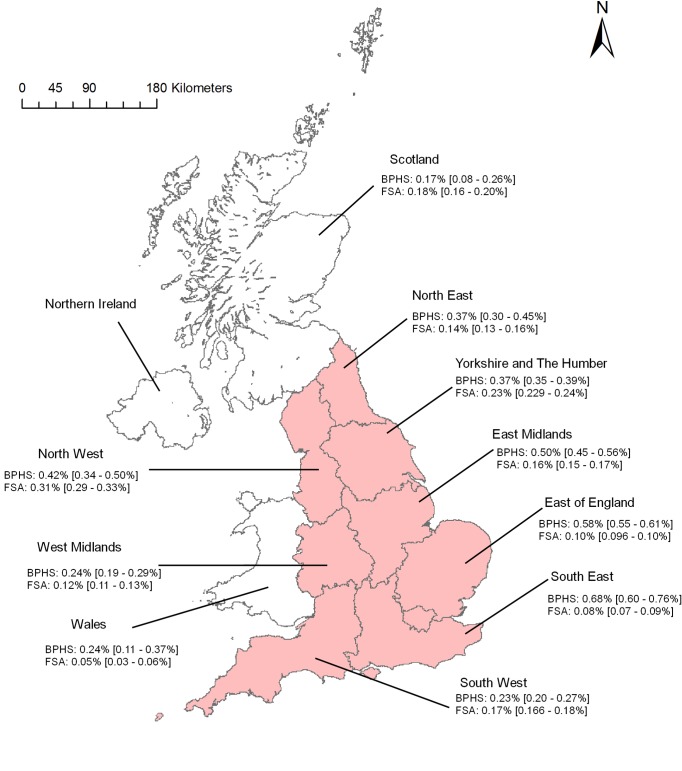
Prevalence of tail bite lesions by UK NUTS1 during the studied period for the two datasets (BPHS and FSA).England is indicated by the regions shown in pink. The 95% confidence interval for the prevalence is within brackets.